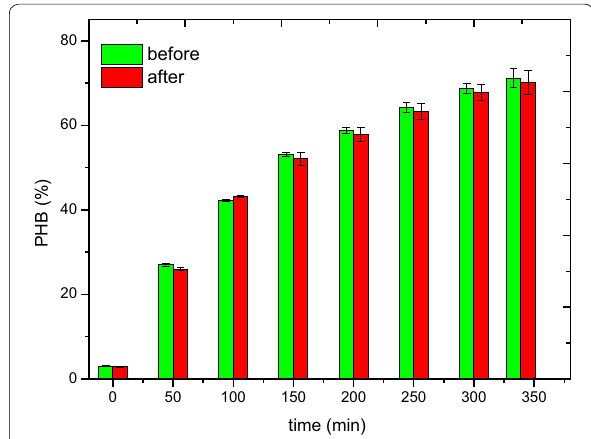
Table 2 Overview of PHB accumulating performance in SBR, FD and batch experiment